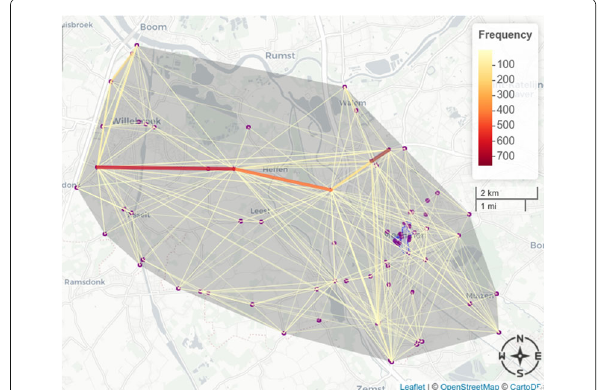
Fig. 28 ANPR: HGVs trajectories (per pair counting both directions)